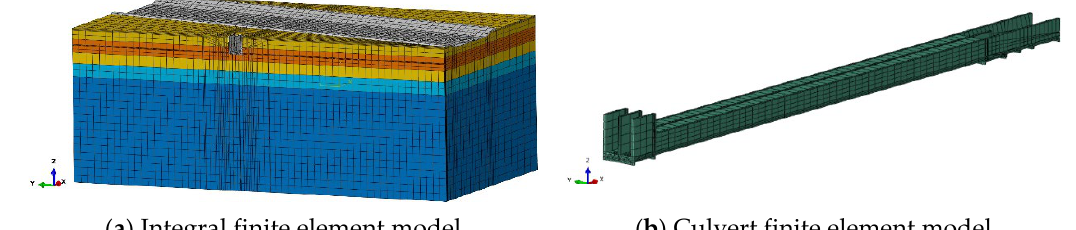
Figure 4. Three-dimensional finite element model.